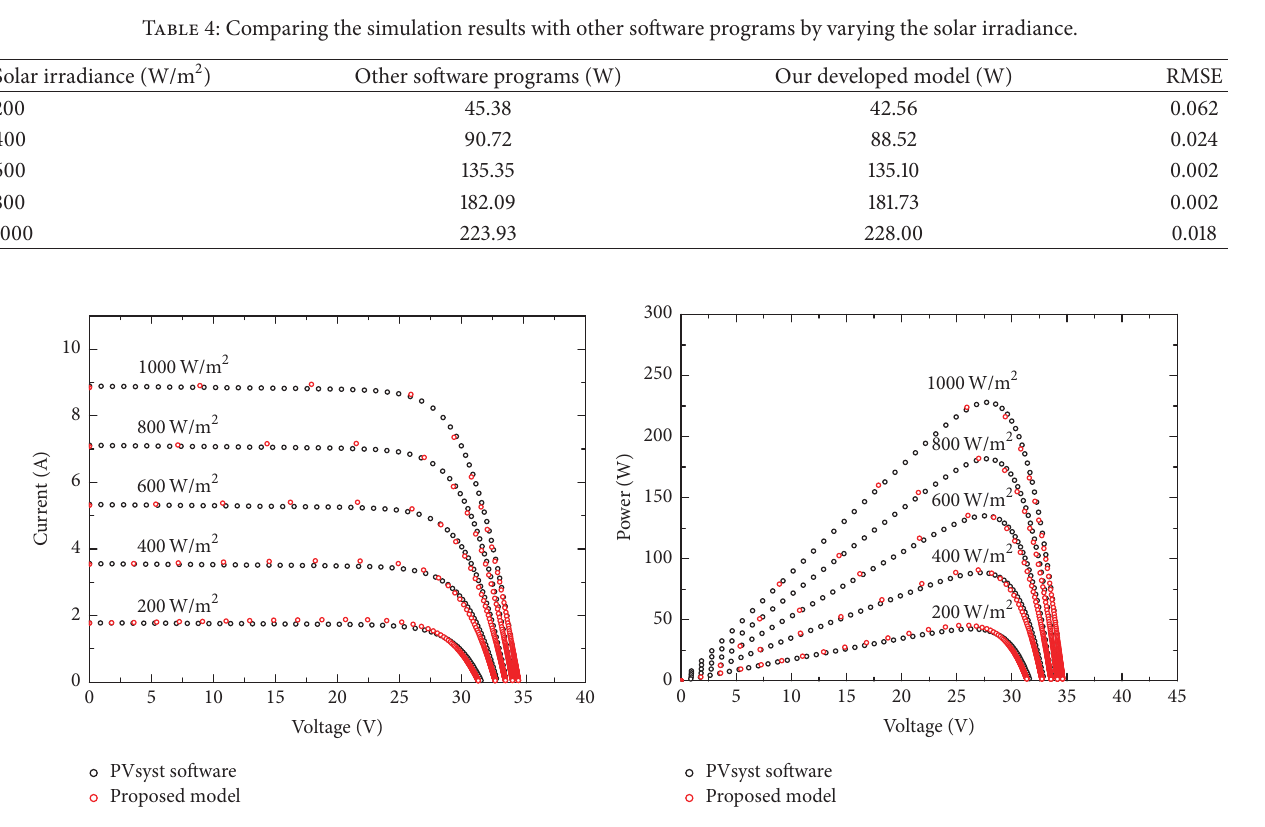
solar irradiances. It can be seen that RMSE values are very low in range (0.002 to